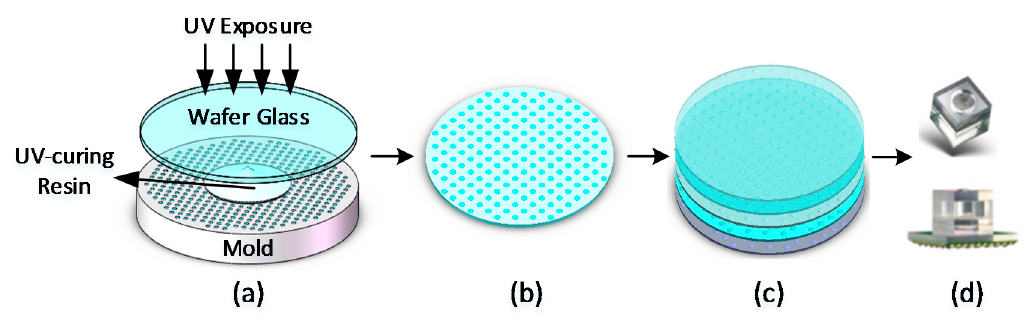
Figure 1. Wafer-level camera fabrication and assembly process, which creates extremely thin camera modules: ( a ) replication of microlens array using a mold, ( b ) wafer-level microlens array, ( c ) wafer-to-wafer bonding, and ( d ) dicing of wafer stack and bonding of the lens module to the sensor. UV: ultraviolet.